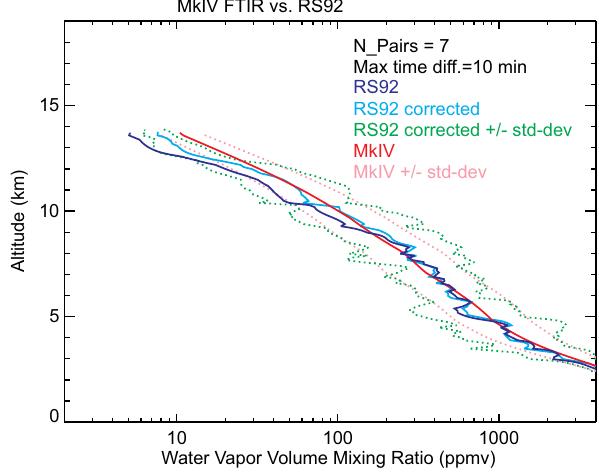
Fig. 9. Tropospheric water vapor mixing ratio profiles measured simultaneously by in-situ and passive remote sensing instruments and techniques on 18 October 2009 (daytime launch).